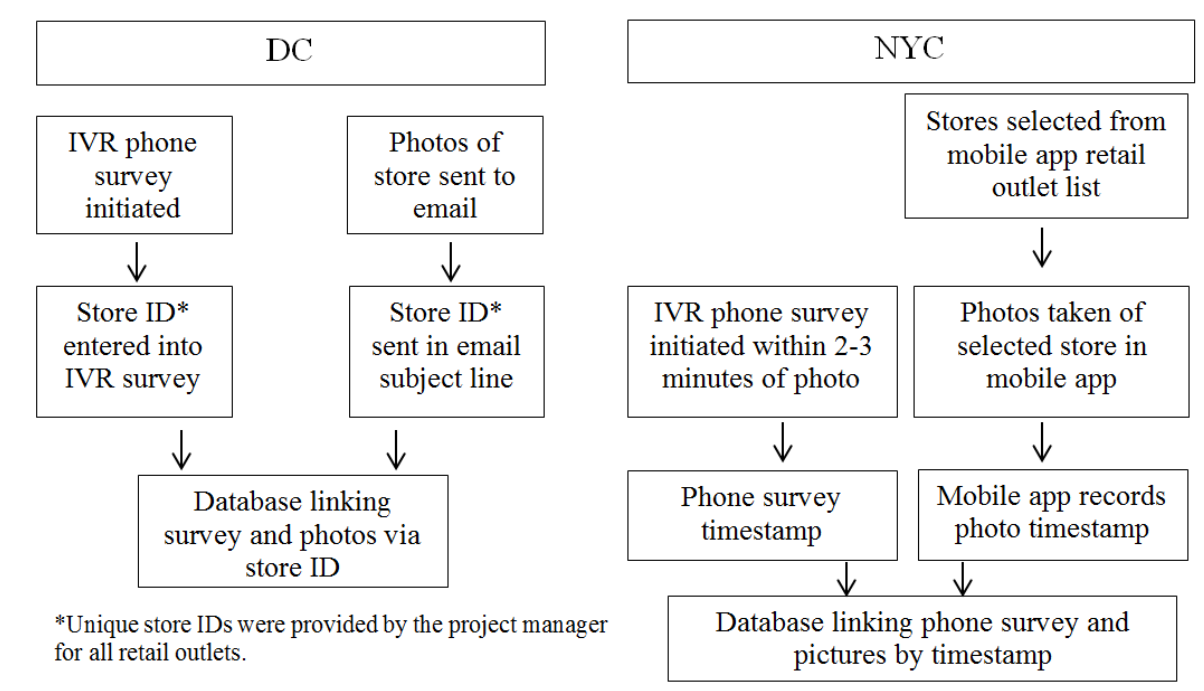
Figure 3. Linkage process for store survey and photo data by